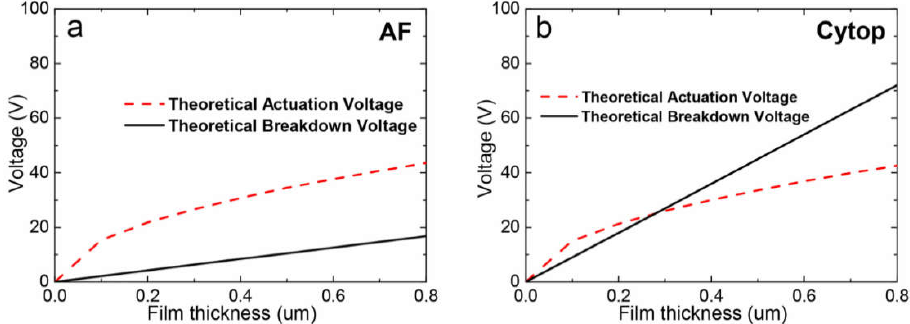
Figure 1. The calculated electrowetting actuation voltage ( E w = 0.34) and the theoretical breakdown voltage, dependent on film thickness, of ( a ) Teflon AF coatings and ( b ) Cytop coatings.